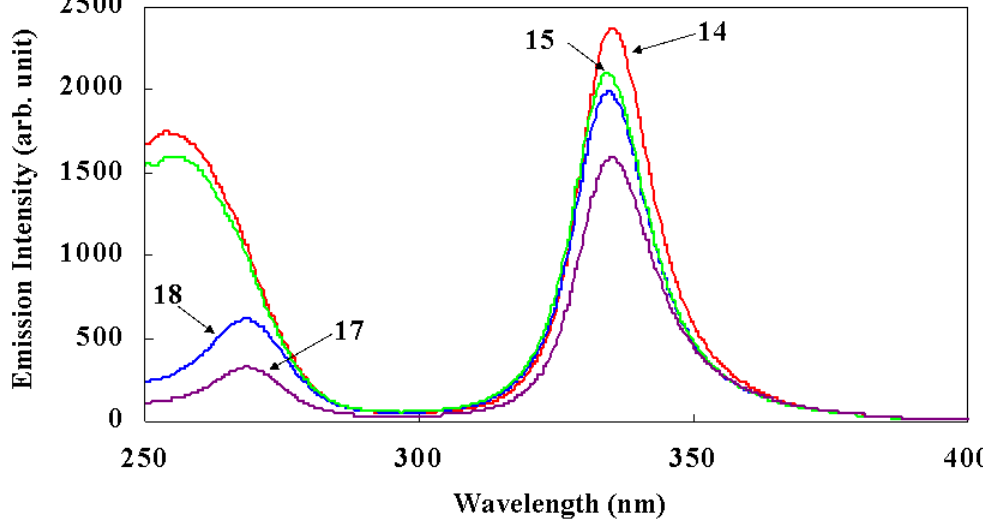
Figure 12. Comparison of the excitation spectra of Eu(III) complexes 17 and 18 , which have thienyl groups in non-symmetric phosphine oxides, with the spectra of complexes 14 and 15 , which have phenyl groups (measured in CCl excited at 336 nm